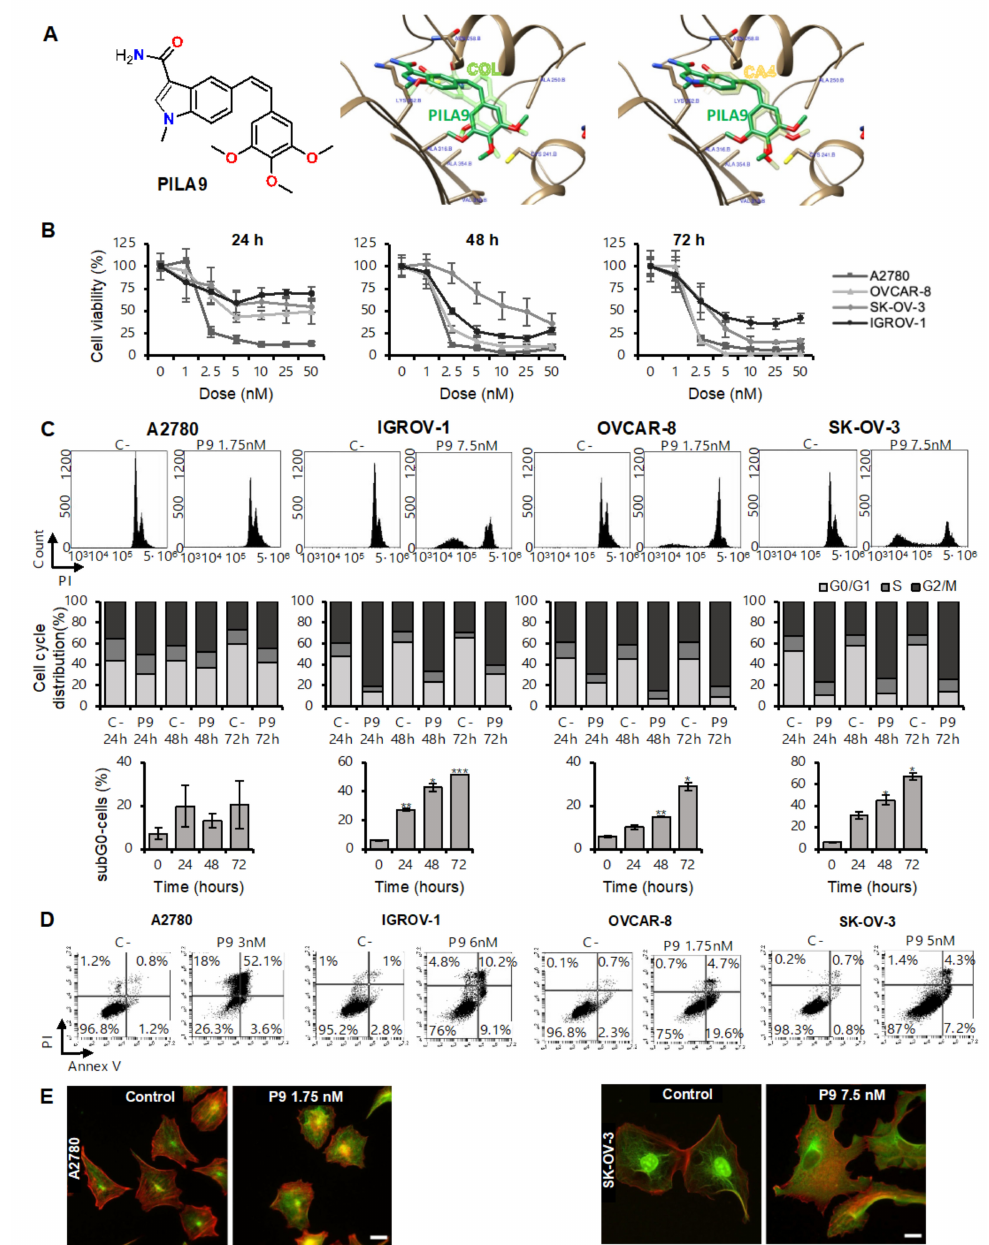
Figure 4. Effect of PILA9 in proliferation, cell cycle distribution, apoptosis, and microtubule network in OCCLs. ( A ) Left panel: chemical structure of PILA9 . Right panel: Consensus docking pose of the indolecombretastatin PILA9 at the colchicine site of tubulin. Colchicine (COL)/Combretastatin A4 (CA4) is also shown for comparison. ( B ) Cell viability after treatment with the indicated doses of PILA9 for 24, 48, and 72 h. ( C ) Top panel, cell cycle profile after PILA9 treatment for 72 h. Middle panel, cell cycle distribution of OCCLs in the absence of treatment (C-) or after PILA9 treatment for 24, 48, and 72 h, excluding the sub-G0 population. Bottom panel, percentage of death cells (subG0) after 24, 48, or 72 h of treatment with PILA9 . ( D ) Dot plots showing alive cells (annexin V − /PI − ), apoptotic (annexin V+), and necrotic (PI+) cells after 72 h of PILA9 treatment. ( E ) Effect of PILA9 on microtubule network. A2780 and SK-OV-3 were treated or not with PILA9 for 24 h and α -tubulin (green) and actin (red) levels were observed by immunofluorescence. C-: negative control (untreated cells). Data are the mean of three independent experiments. Error bars represent the SD (*** p < 0.001; ** p < 0.01, * p < 0.05). Scale bar: 10 µ